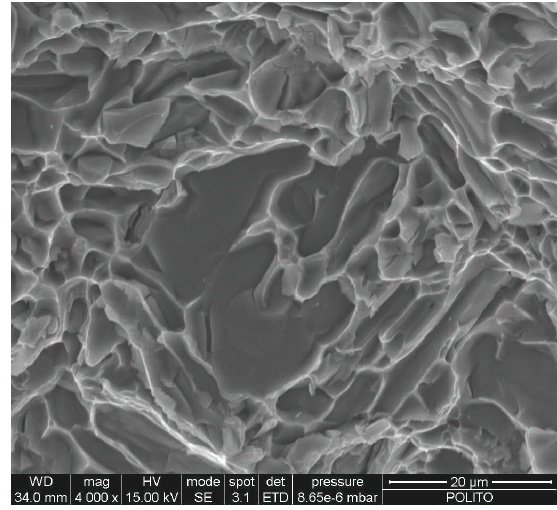
Figura 4: Superficie di frattura per fatica a temperatura ambiente in una lega AlSi7Mg-T6 [1]. Figure 4: Fatigue fracture surface in an AlSi7Mg-T6 alloy at Room Temperature